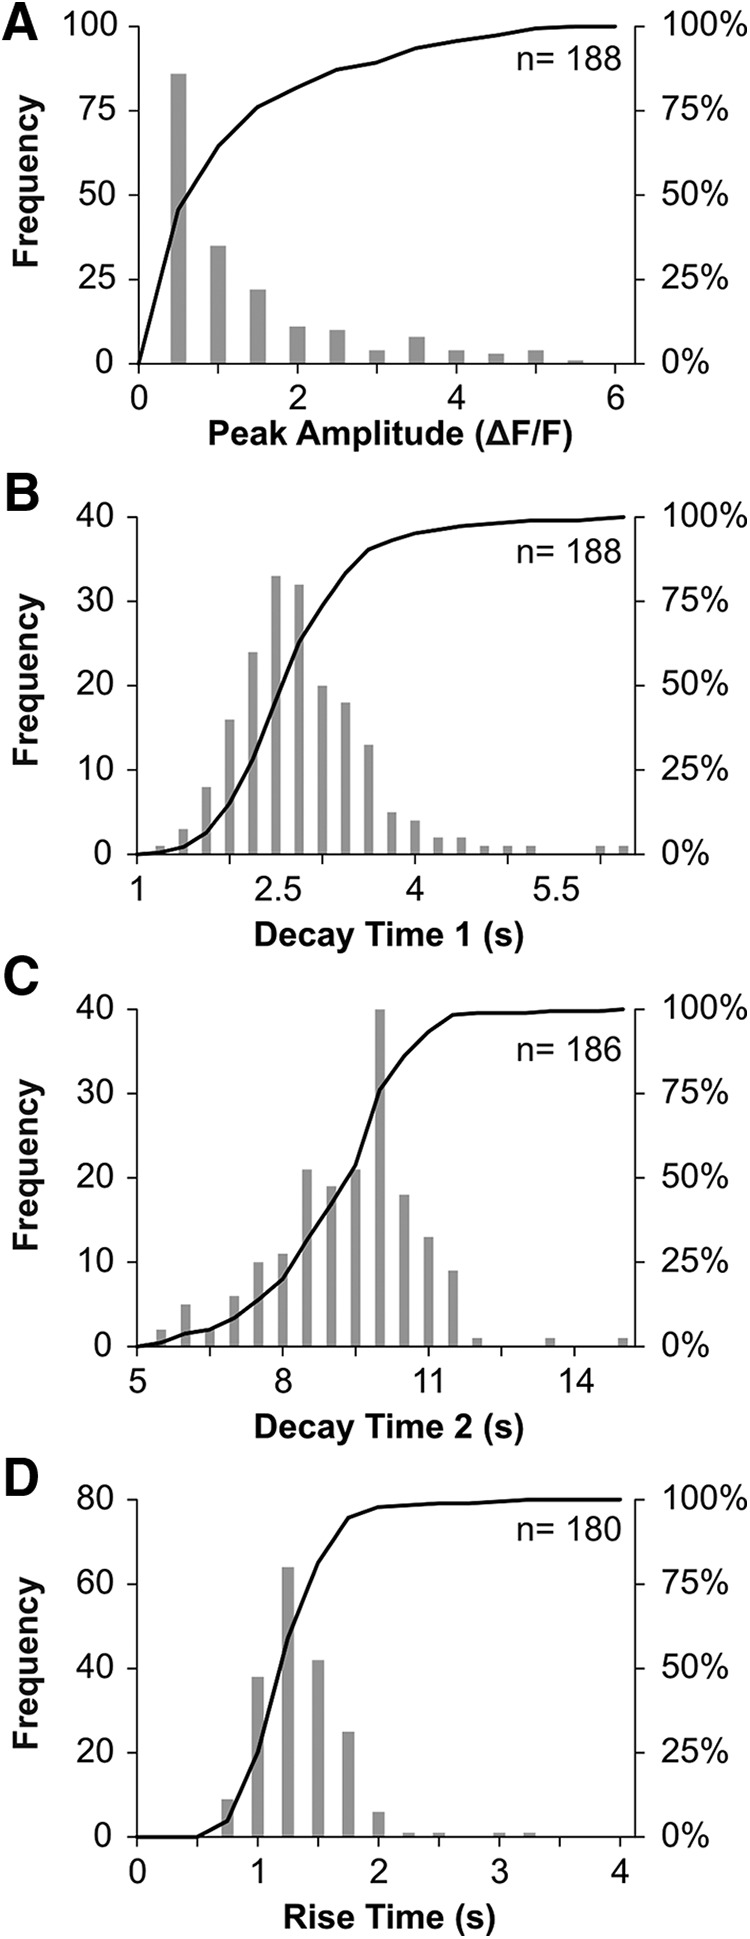
Histograms illustrating distributions of four parameters quantified from each cell imaged. A–D, Frequency (gray boxes) and cumulative (black line) histograms for each parameter. Sample size for each parameter is given in the upper right-hand corner. Distributions do not show evidence of multimodality.